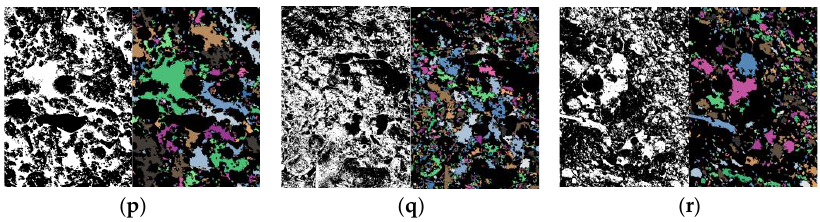
Figure 10. Binarization of CGFB microscopic pores. ( a ) A-1; ( b ) A-2; ( c ) A-3; ( d ) B-1; ( e ) B-2; ( f ) B-3; ( g ) C-1; ( h ) C-2; ( i ) C-3; ( j ) D-1; ( k ) D-2; ( l ) D-3; ( m ) E-1; ( n ) E-2; ( o ) E-3; ( p ) F-1; ( q ) F-2; ( r ) F-3. Table 3. Region percentage (porosity) of CGFB samples.